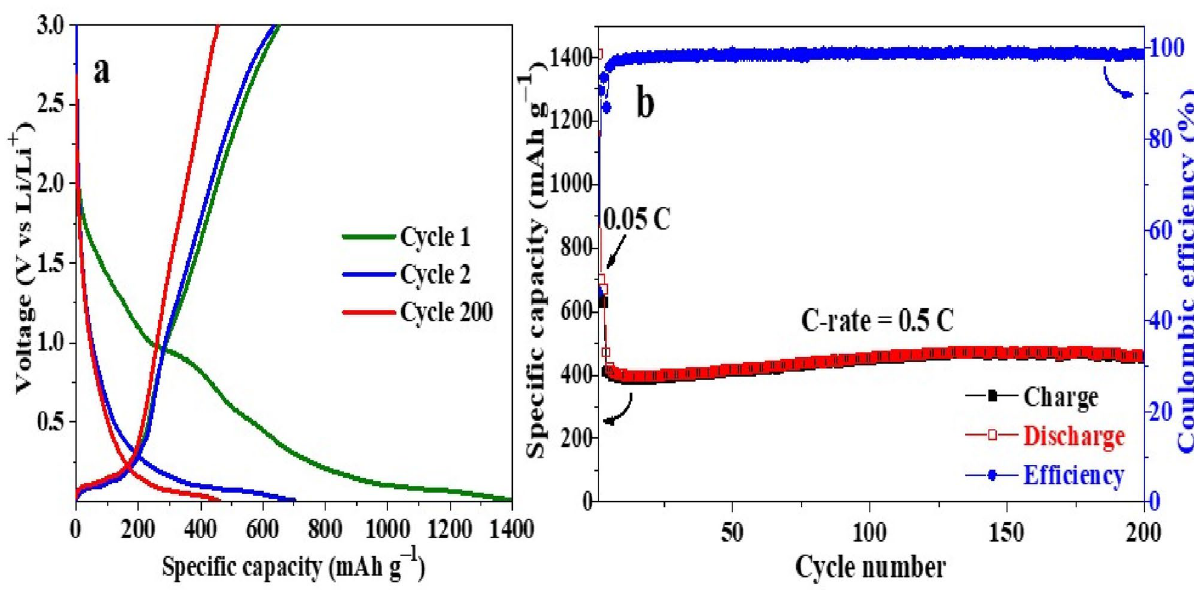
Figure 8. Electrochemical cycling performance of the MXene sample, Ti x Ta (4−x) C 3 : ( a ) (dis)charge profiles at cycle 1st, 2nd and 200th, ( b ) cycle performance after 200 cycles at C-rate of 0.5